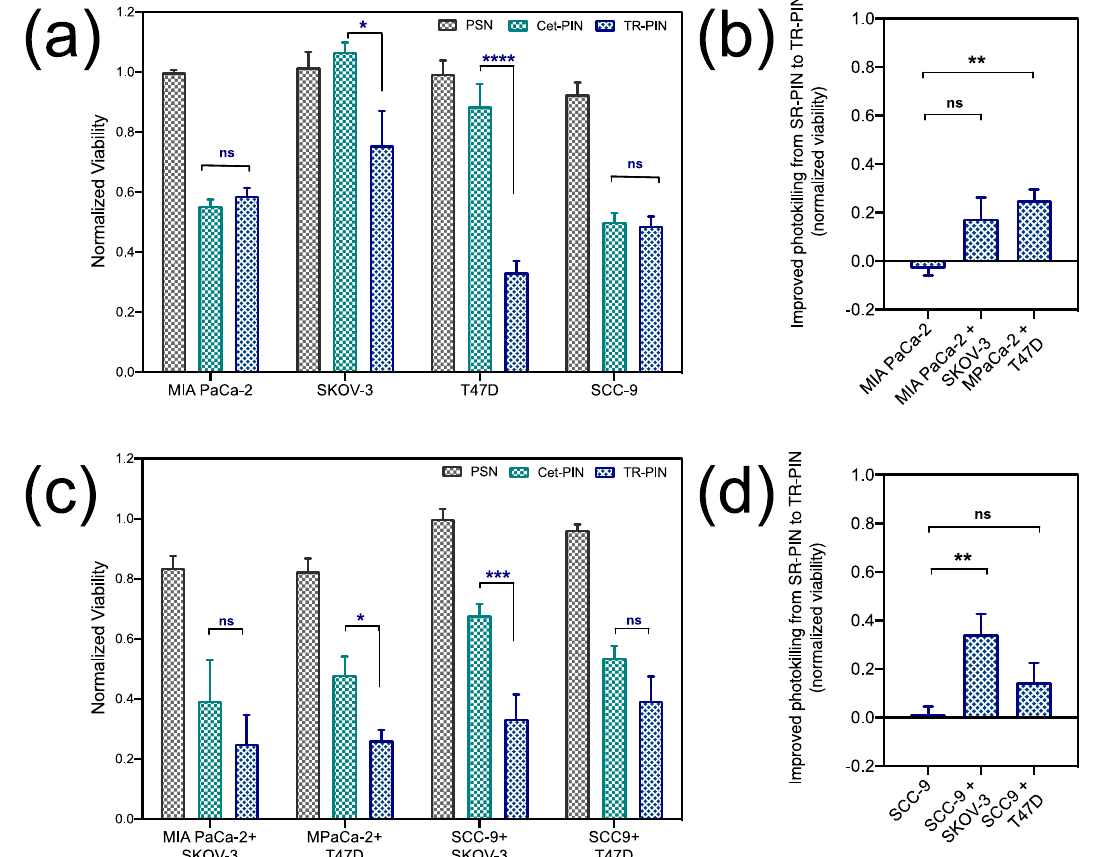
Figure 8. NIR light-mediated photodynamic treatment of 3D co-cultures of MIA PaCa-2 and SCC-9 cells with SKOV-3 and T47D cells. The CALYPSO image analysis framework was used for quantitation of normalized viability of ( a ) 3D monocultures and ( b ) co-cultures following PDT with untargeted-PSNs, Cet-targeted PINs (Cet-PINs), and triple-receptor-targeted TR-PINs, at a concentration of 500 nM of BPD-PC equivalent, (690 nm, 40 J / cm 2 at 150 mW / cm 2 ). ( c , d ) A comparison of normalized fractional viability of MIA PaCa-2 and SCC-9 monocultures and co-cultures with T47D and SKOV-3 following PDT with TR-PINs (690 nm, 40 J / cm 2 at 150 mW / cm 2 ). (mean ± S.E.M.; n = 8–12; one-way ANOVA with a Tukey post-test; **** = p ≤ 0.0001; *** = p ≤ 0.001; ** = p ≤ 0.01; * = p ≤ 0.05).